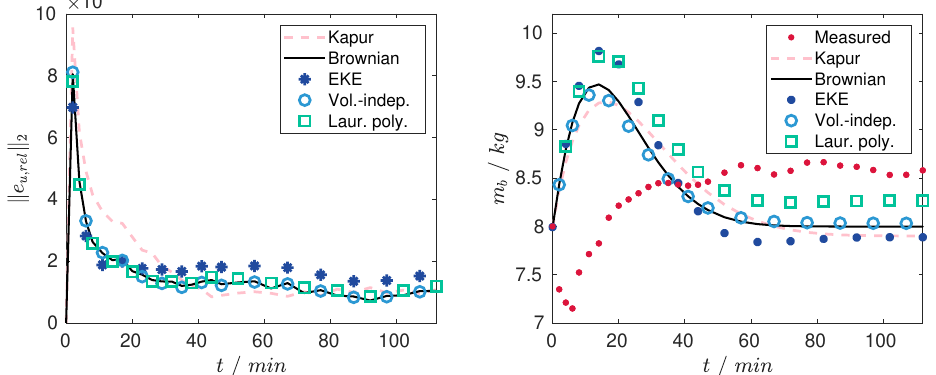
Figure 3. ( Left ) Comparisonof the L 2 norms of the particle size distribution (PSD) error for different kernel candidates ( Right ) Comparison of the actual bed mass and bed masses of the identified models.